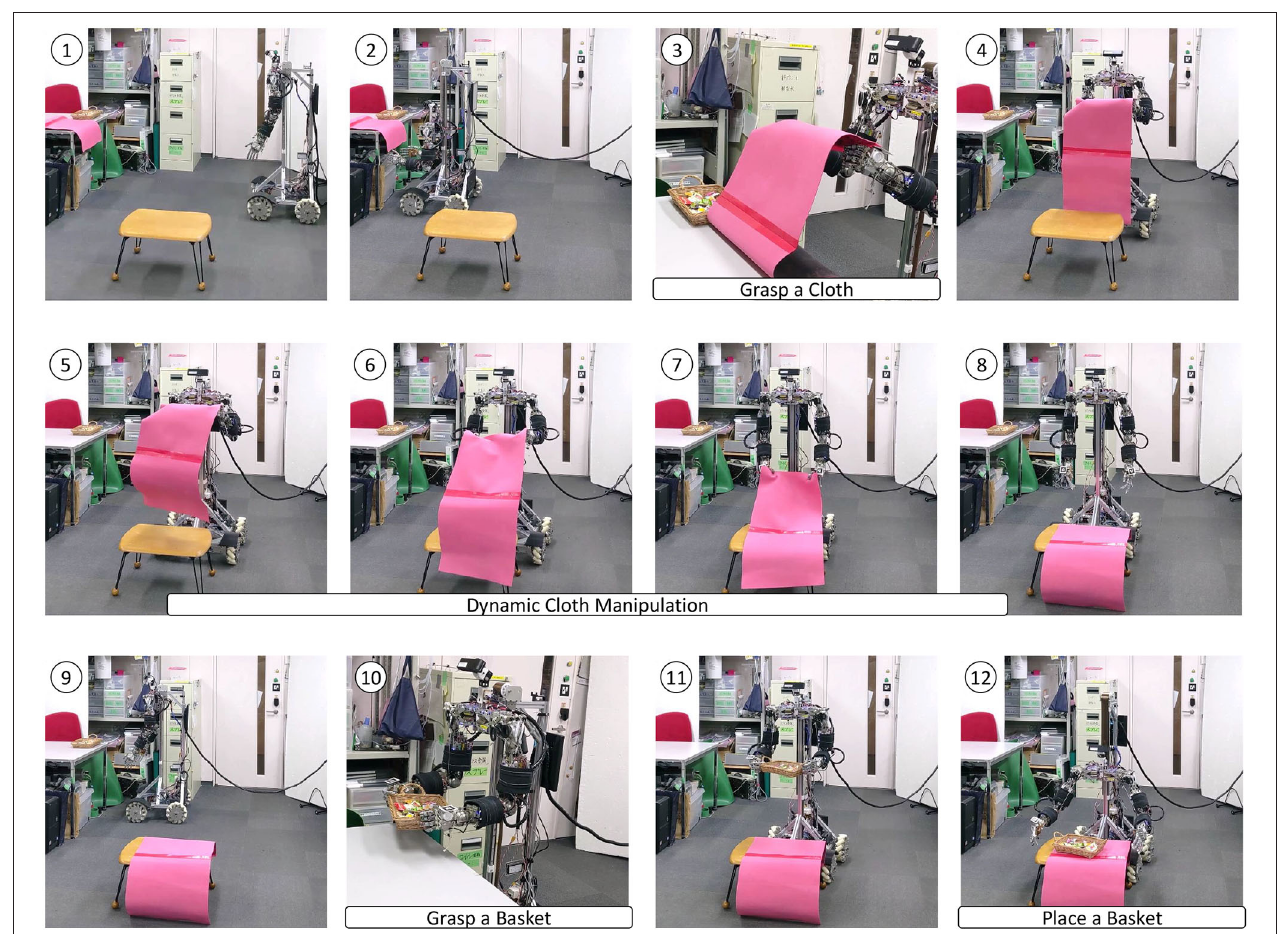
FIGURE 15 | The integrated table setting experiment of grasping a cloth, manipulating it dynamically, and putting a basket on